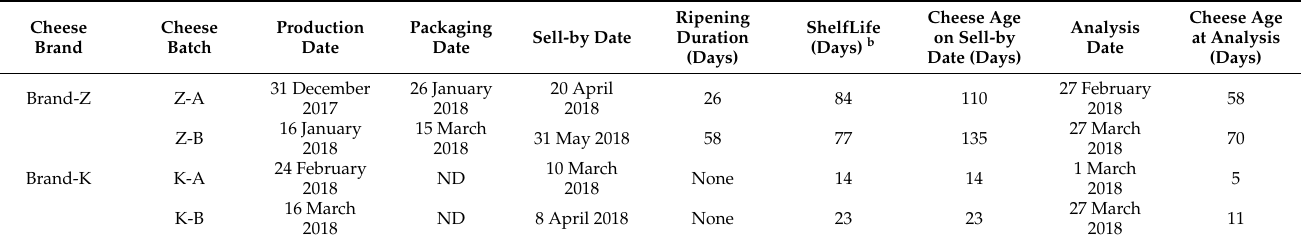
Table 1. Ripening duration and in-package commercial shelflife of two traditional Galotyri PDO cheese products (non-industrial; artisan-type; brand-named) purchased from the market of Ioannina, Epirus a